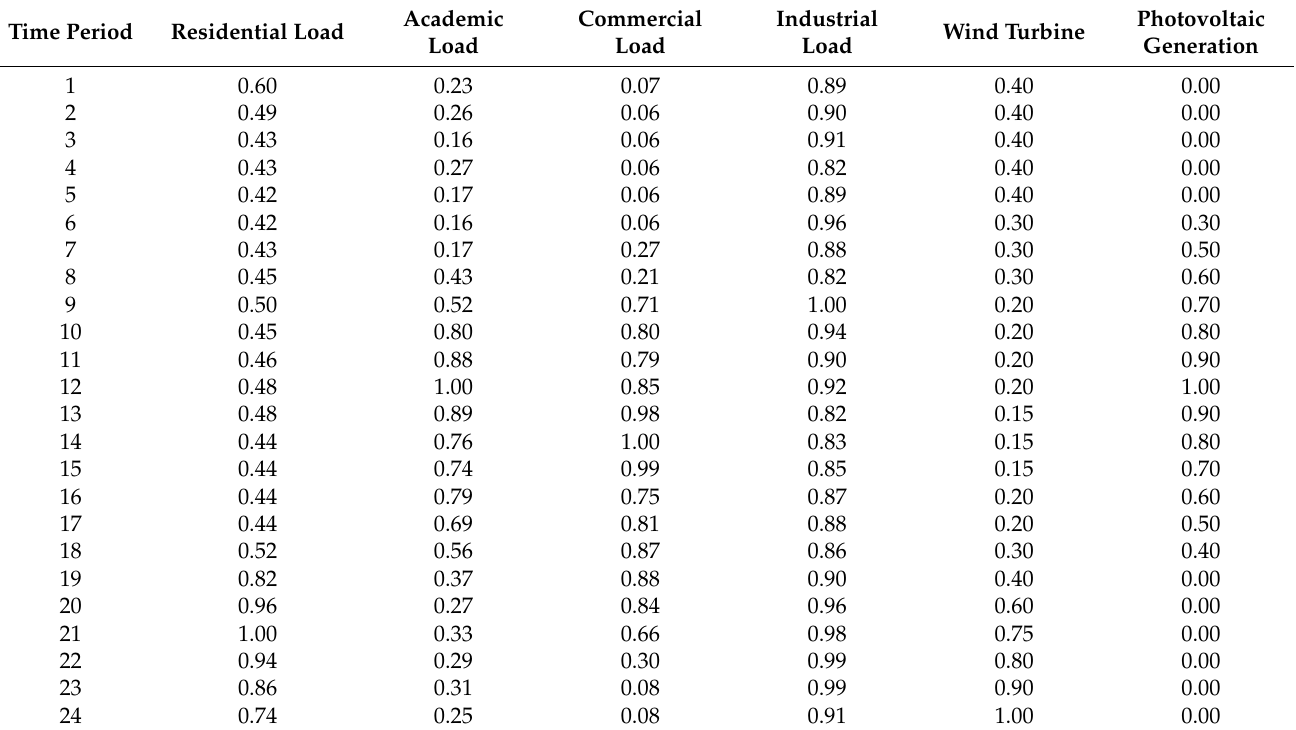
Table 2. Microgrids’ generation and load profiles (from